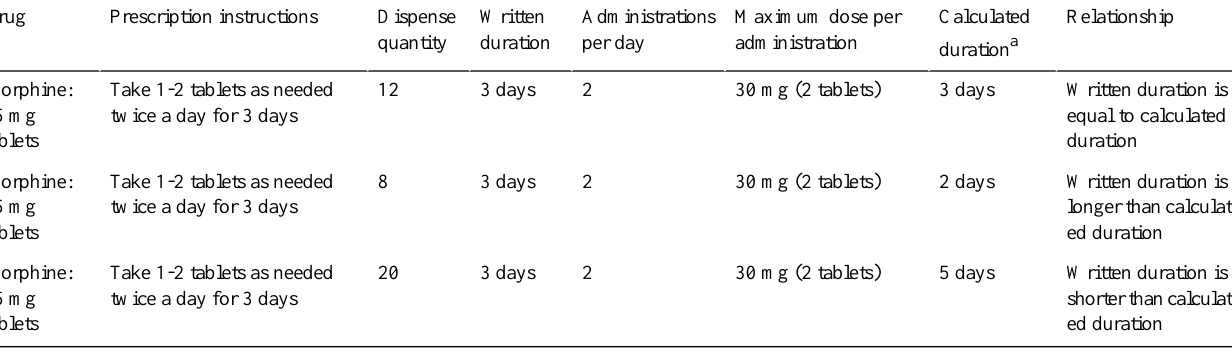
Table 1. Examples of each field extracted from the electronic health record system, with written duration and calculated duration demonstrated, along with their